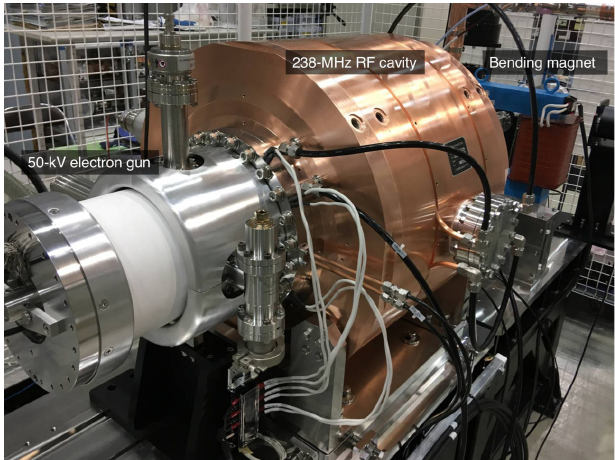
FIG. 10. Beam energy dependence on the rf input power to the 238-MHz rf cavity. The plus signs and solid line represent the measured data and calculation with a shunt impedance of 6 . 17 M Ω for the 238-MHz rf cavity,